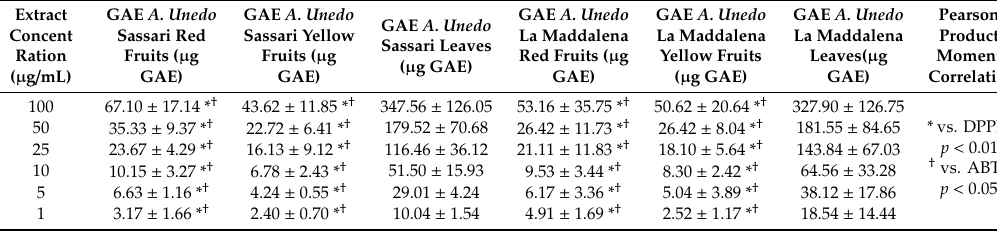
Table 3. Determination of phenols by Folin–Ciocalteu’s